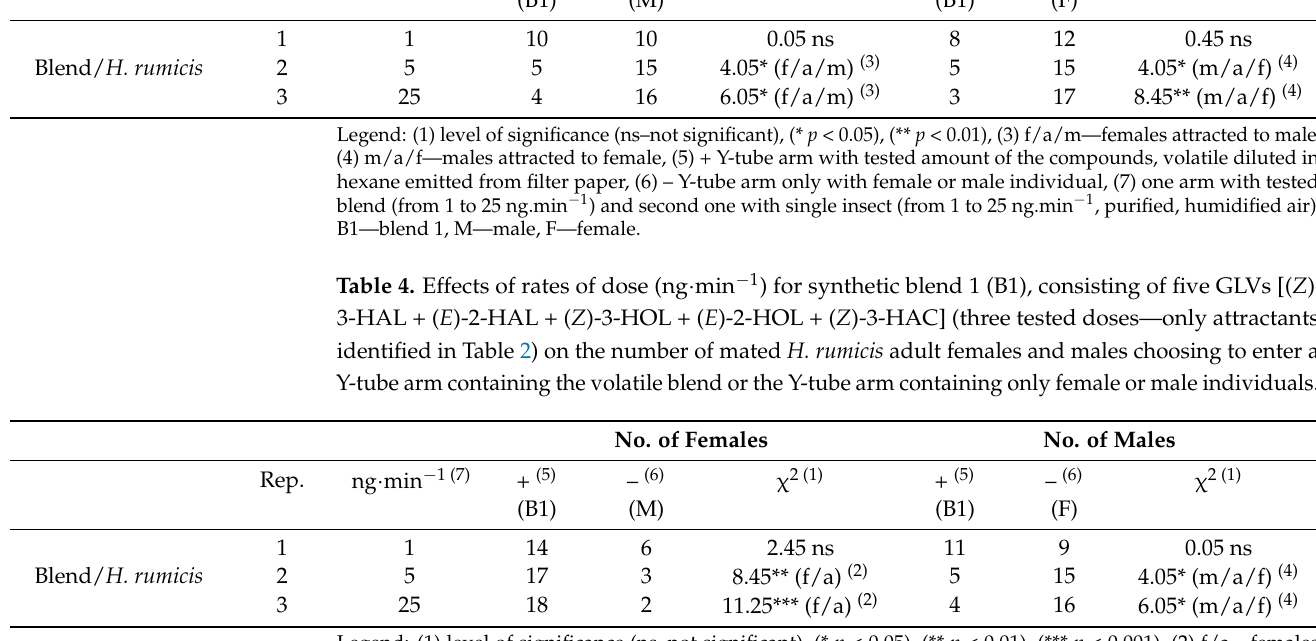
Table 3. Effects of rates of dose (ng · min − 1 ) for synthetic blend 1 (B1), consisting of five GLVs [( Z )- 3-HAL + ( E )-2-HAL + ( Z )-3-HOL + ( E )-2-HOL + ( Z )-3-HAC] (three tested doses—only attractants identified in Table 2) on the number of unmated H. rumicis adult females and males choosing to enter a Y-tube arm containing the volatile blend or the Y-tube arm containing female or male individuals. No. of Females No. of Males Rep.